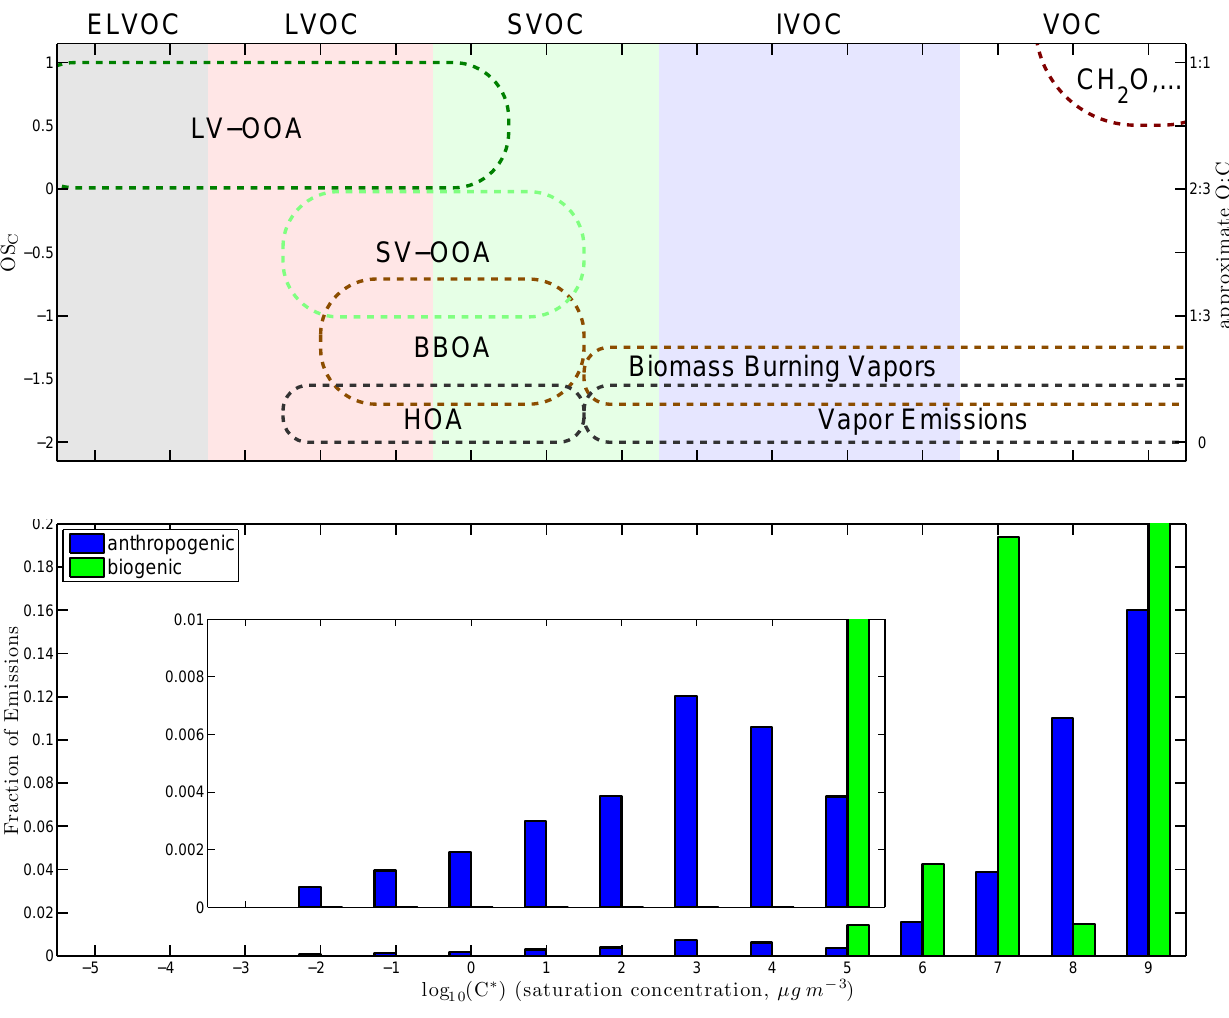
Fig. 1. (a) Volatility ( C ∗ in µg m − 3 ) and oxidation state (OS C ) for important atmospheric organics. Note the enormous range on the (logarithmic) x-axis. The volatility ranges described in the text are indicated by colored bands: aerosols are located in the ELVOC (gray), LVOC (red) and SVOC (green) range. Factors based on ambient aerosol-mass-spectrometer (AMS) observations are shown to the left, in the condensed-phase region. The OS C of ambient aerosol is constrained by high-resolution AMS measurements, while the volatility is constrained by thermodenuder measurements. Oxidation chemistry drives organic material monotonically upwards in this space, toward ultimate (volatile) products CH 2 O, shown in the upper right, and CO and CO 2 at OS C = 2 and 4. Ranges for primary emissions are shown as bands along the low OS C region of the space. (b) Emissions vs. volatility in the continental United States. Fluxes are shown for anthropogenic (pyrogenic) and biogenic emissions, as a fraction of total emissions. Emissions are very heavily weighted toward the volatile end of the range – the primary OA AMS factors (HOA and BBOA) represent the lowest-volatility tails of the pyrogenic flux distributions. The inset magnifies the lower volatility emissions for